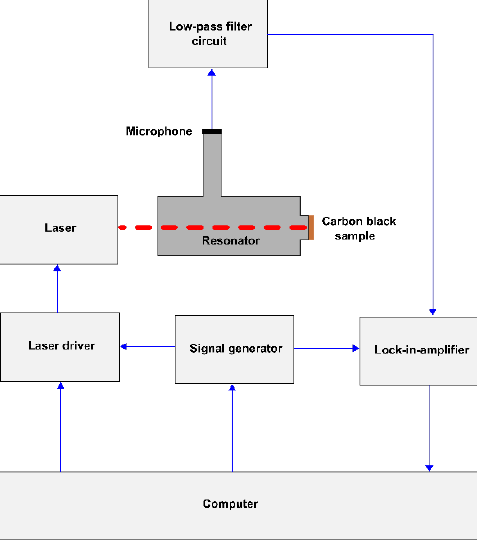
Figure 1. Schematic of the experimental setup.